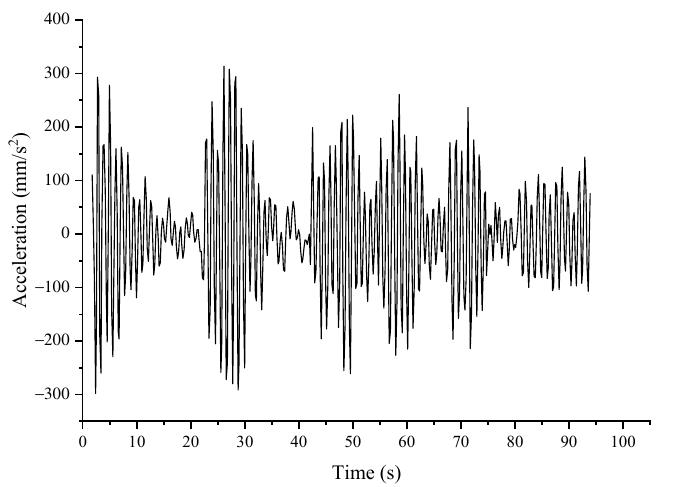
Figure 20. Response accelerations at the ToF under ultimate ice conditions (ice thickness was 0.32 m and ice velocity was 0.75 m·s − 1 ).